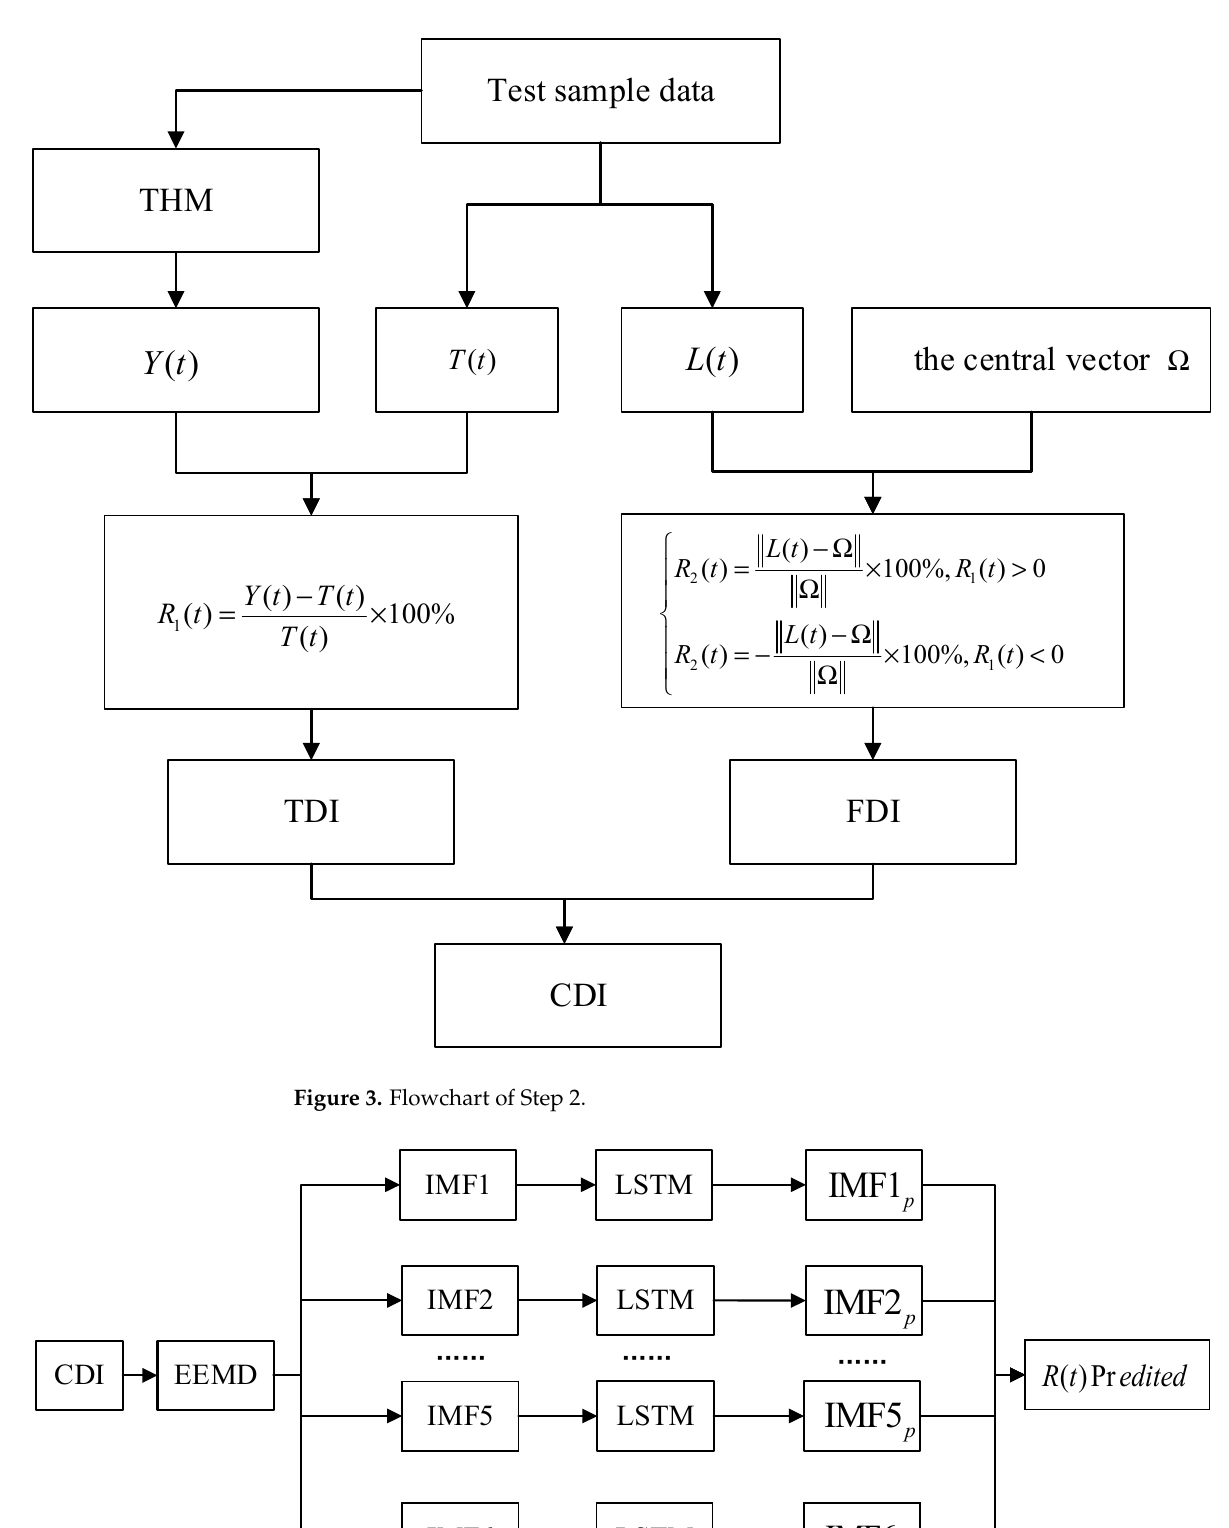
Figure 4. Flowchart of Step 3.